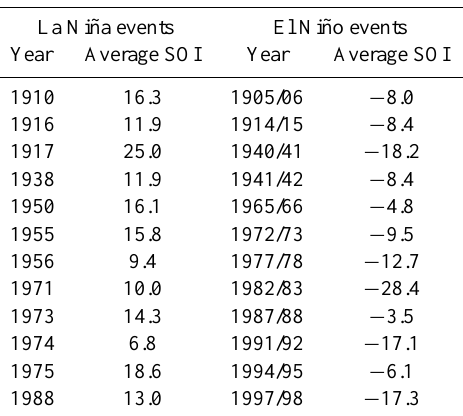
Table A1. Average values of SOI (Southern Oscillation Index) for twelve La Niña and El Niño events,